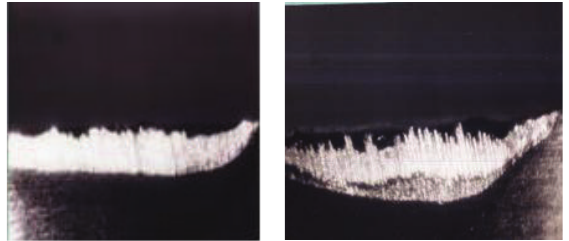
Figure 4: Tool wear of tool K10 ( 𝑁 = 2000 ∼ 𝑁 = 5000 rpm).